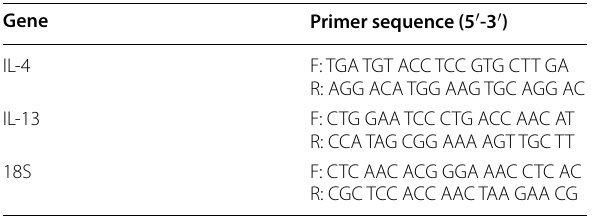
Table 2 Oligonucleotide primer sequences used for